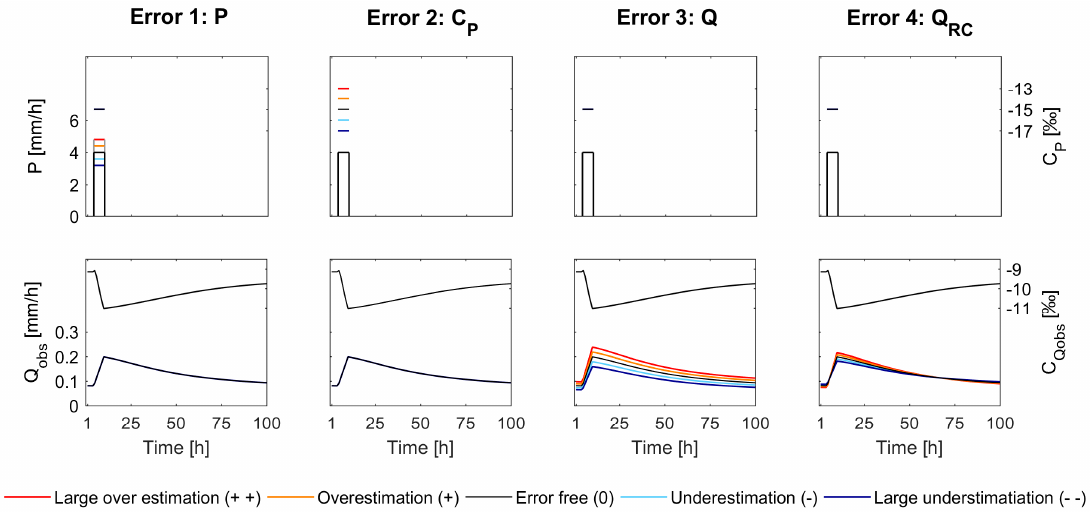
Figure 1. The effect of the four observation errors on the input data ( first row ), the streamflow and stream isotope data used for calibration ( second row ) for the four different error magnitudes (+ +, +, − , − − ) and the error free case (0) for the medium event and model parameter set PI. P (precipitation intensity) and C P (isotopic composition of the precipitation) are the input data used for model calibration and include observation errors for Errors 1 and 2, Q obs and C Qobs are the observed streamflow and isotopic composition of stream water that were used for model calibration, Q obs includes observation errors for Errors 3 and 4.